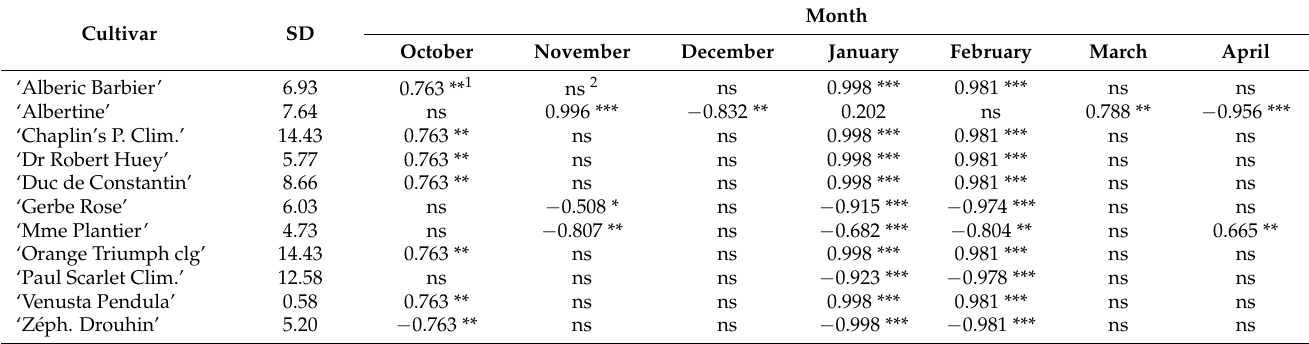
Table 10. The effect of correlations between average monthly air temperature (2005/2006, 2009/2010, and 2015/2016) and the start of the flowering period (BBCH 60 601) in climber roses.